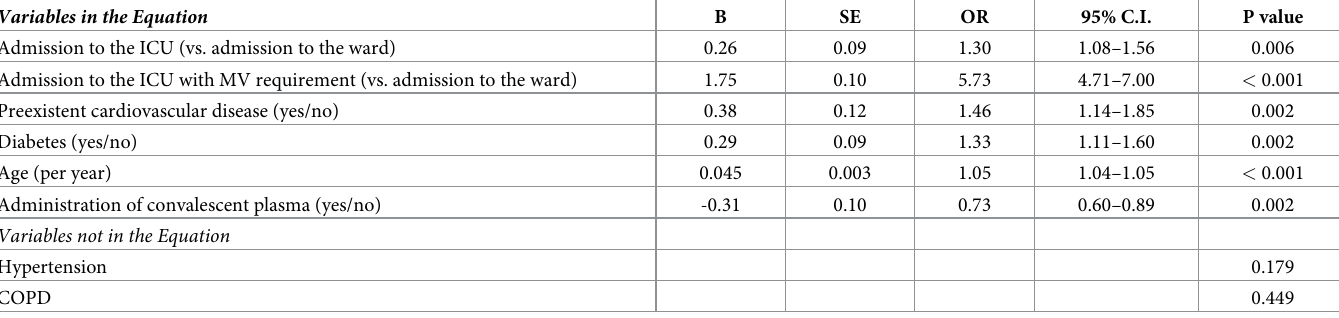
Table 3. Independent predictors of 28-day mortality, as identifies with logistic regression. Variables in the Equation